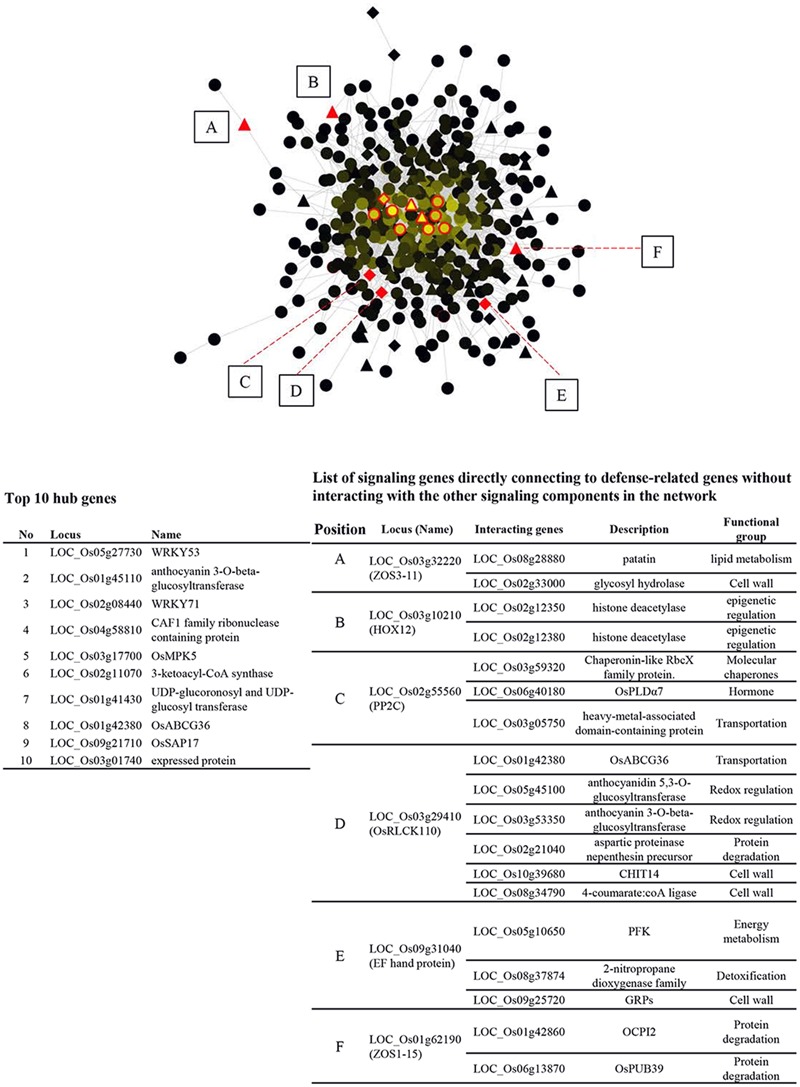
Regulatory network of GSR genes in rice. GSR genes were queried against RiceNet v2 and the data retrieved were imported into Cytosape (V3.2.1) to generate the regulatory network. Brightness of a node is proportional to the number of connection to other nodes. TFs are represented by triangles, while signaling genes are represented by diamonds. The other genes are represented by circles. The top ten hub nodes (most connected) in GSR regulatory network were shown in red edges and were listed in the lower left panel. Solid red triangles or diamonds (TFs or signaling genes) marked from A to E lack connection to other TFs or signaling genes and are connected to defense-related genes directly. These genes and their interacting partners were listed in the lower right panel.